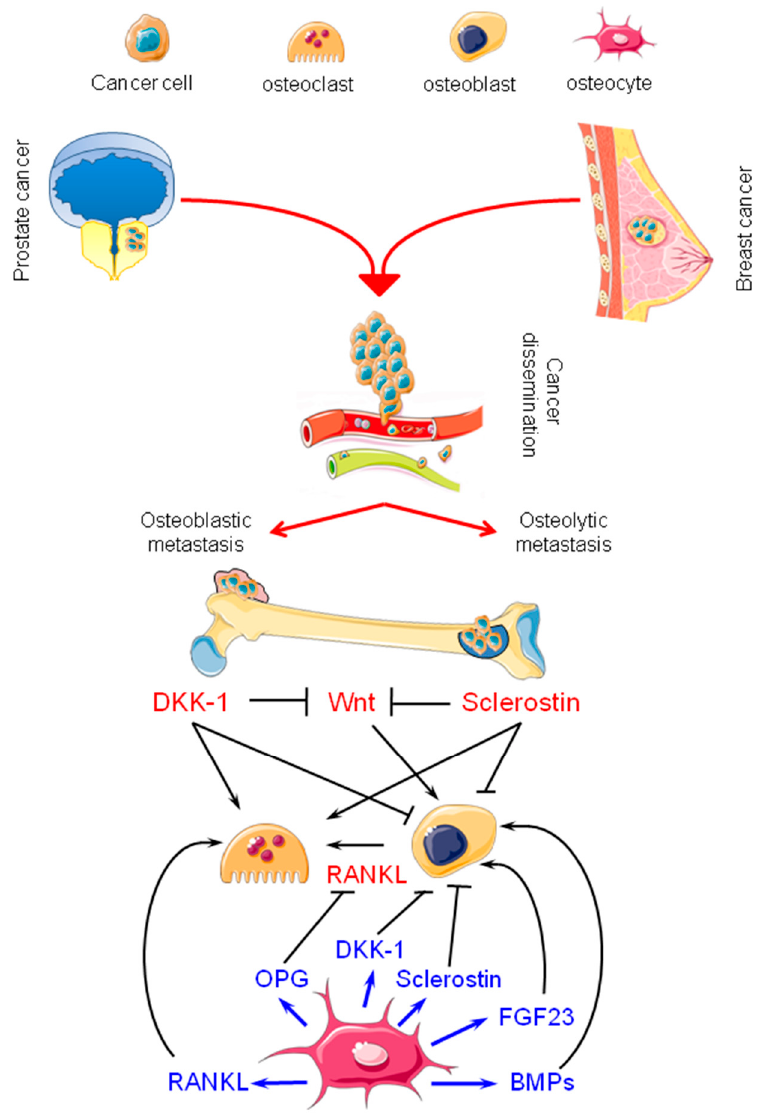
Figure 1. Overview of the effects of osteocyte products on osteoclasts and osteoblasts during bone metastasis. Also shown are the effects on osteoblasts and osteoclasts of sclerostin and DKK-1 produced by breast and prostate cancer cells at the metastatic site. DKK-1: Dickkopf-1; Wnt: Wingless- related integration site; RANKL: receptor activator of nuclear factor kappa B ligand; OPG: osteoprotegerin; FGF23: fibroblast growth factor 23; BPM: bone morphogenetic protein. (Figure created, with small modifications, using Servier Medical Art available at https://smart.servier.com).